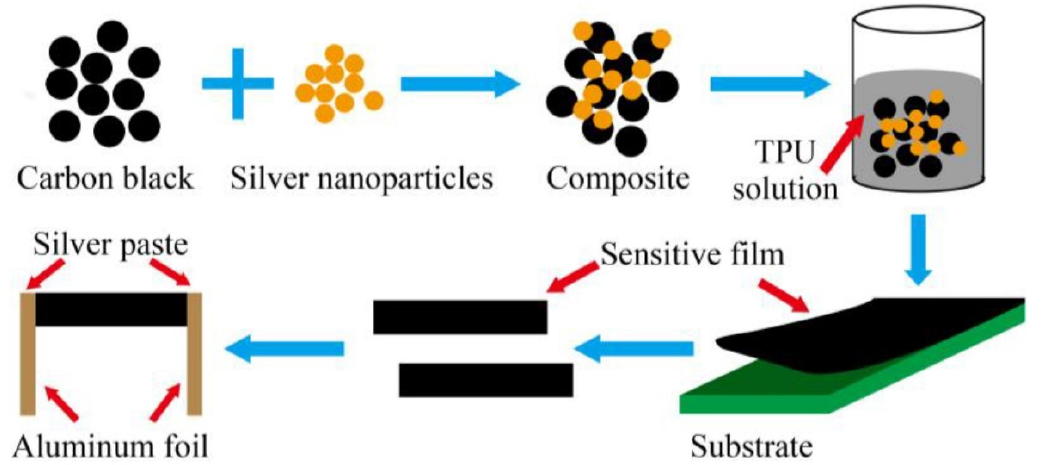
Figure 6. Schematic illustration of the fabrication process of the carbon black/silver nanoparticles/ thermoplastic PU nanocomposites-based strain sensors [138].